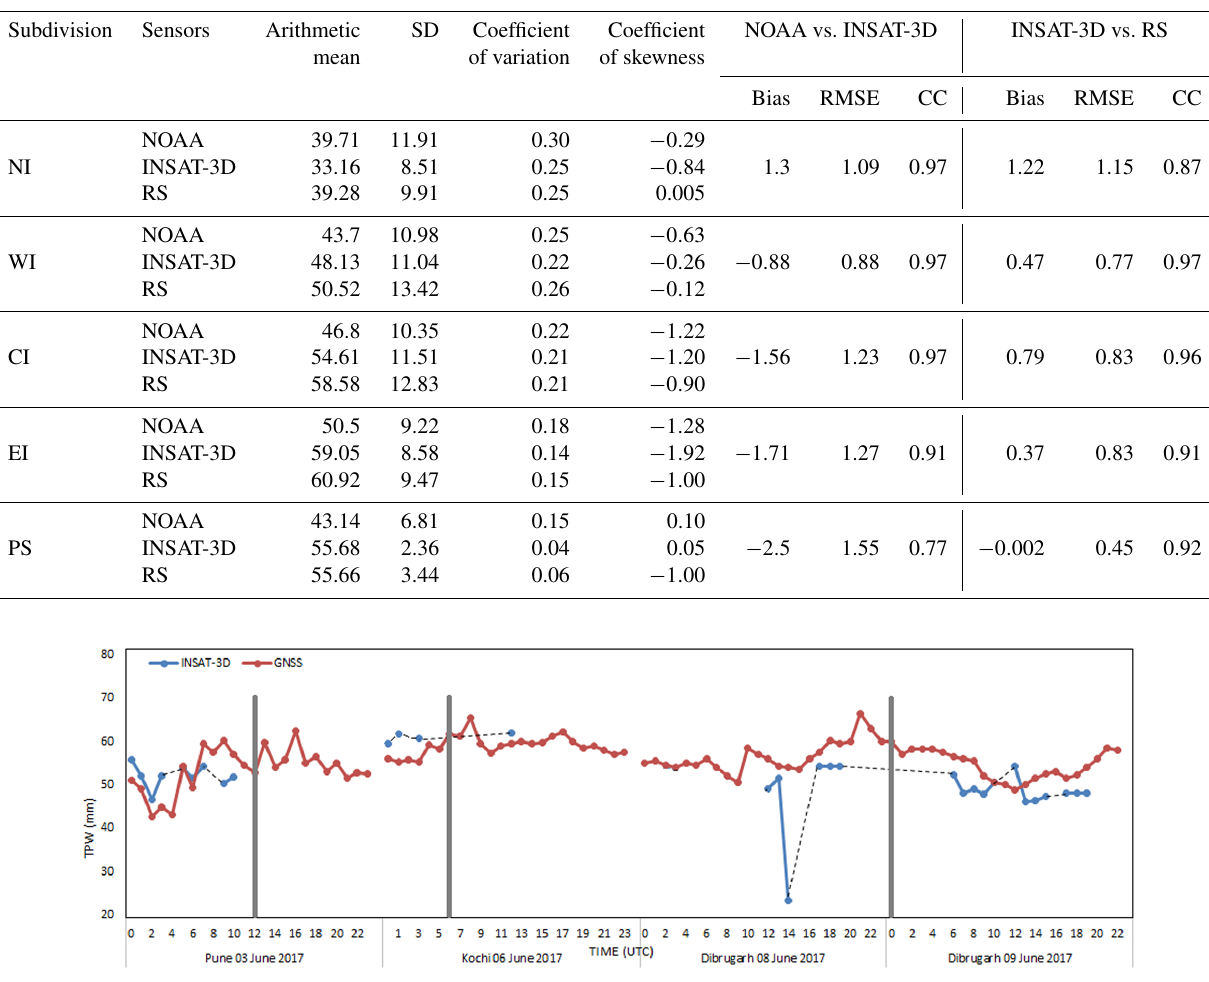
vection development starts at 01:00 UTC. INSAT-3D TPW shows the higher TPW values around 58 mm in